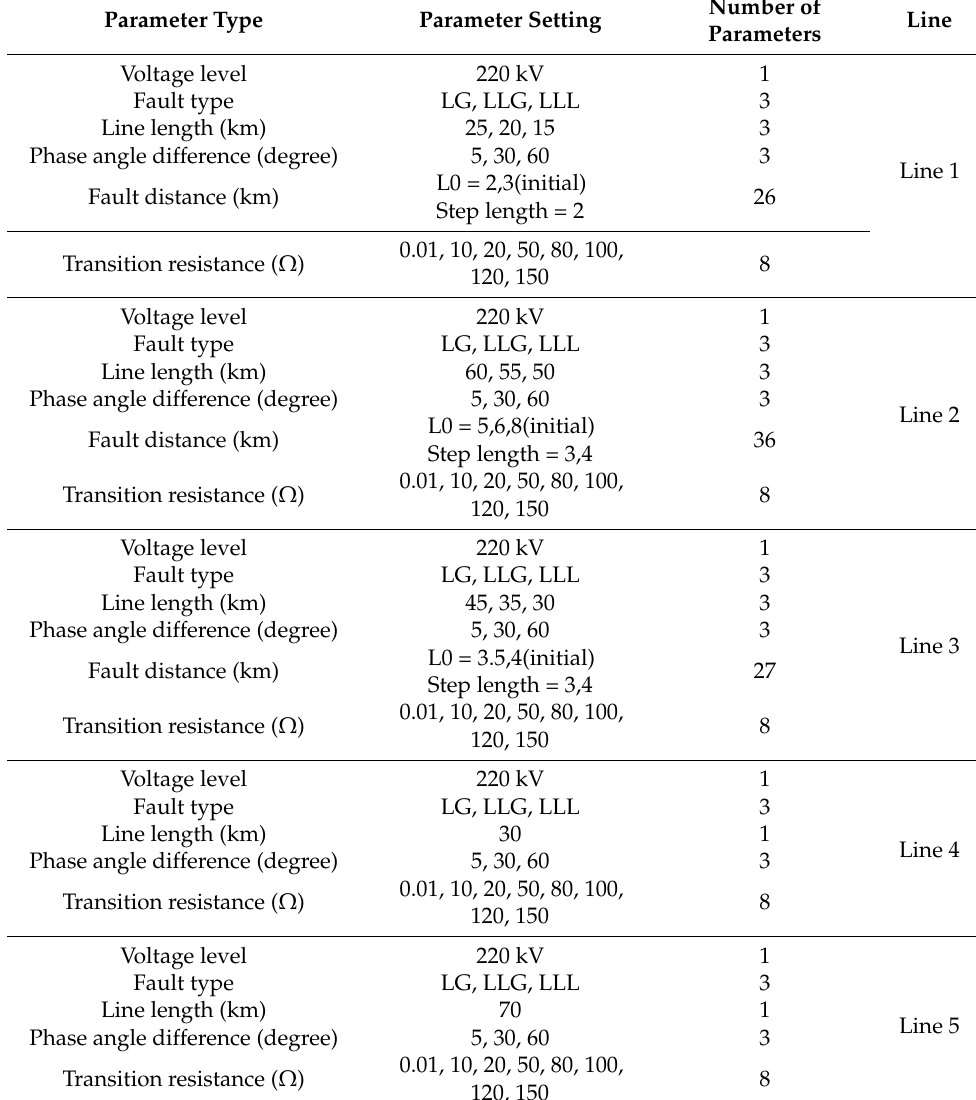
Table A3. Fault settings for different lines.